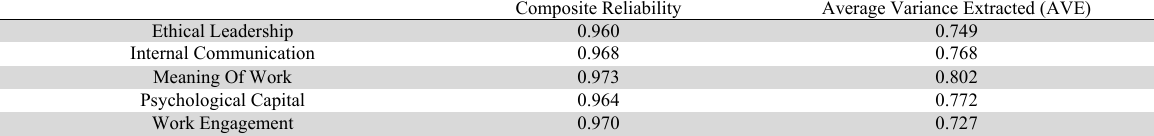
Average Variance Extracted (AVE) and Composite Reliability (CR)